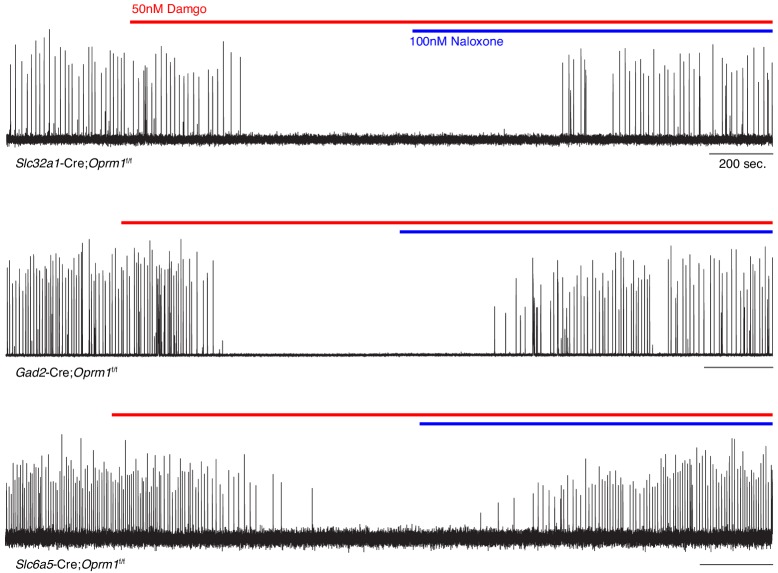
preBötC slice activity in 50 nM DAMGO after deletion of Oprm1 from inhibitory neural types.Representative recording of bursting activity at baseline, after application of 50 nM DAMGO (red line), and 100 nM Naloxone (blue line). Top: Slc32a1-Cre;Oprm1f/f targeting GABAergic neurons (n = 2). Middle: Gad2-Cre;Oprm1f/f targeting GABAergic neurons (n = 6). Bottom: Slc6a5-Cre;Oprm1f/f targeting Glycinergic neurons (n = 4).